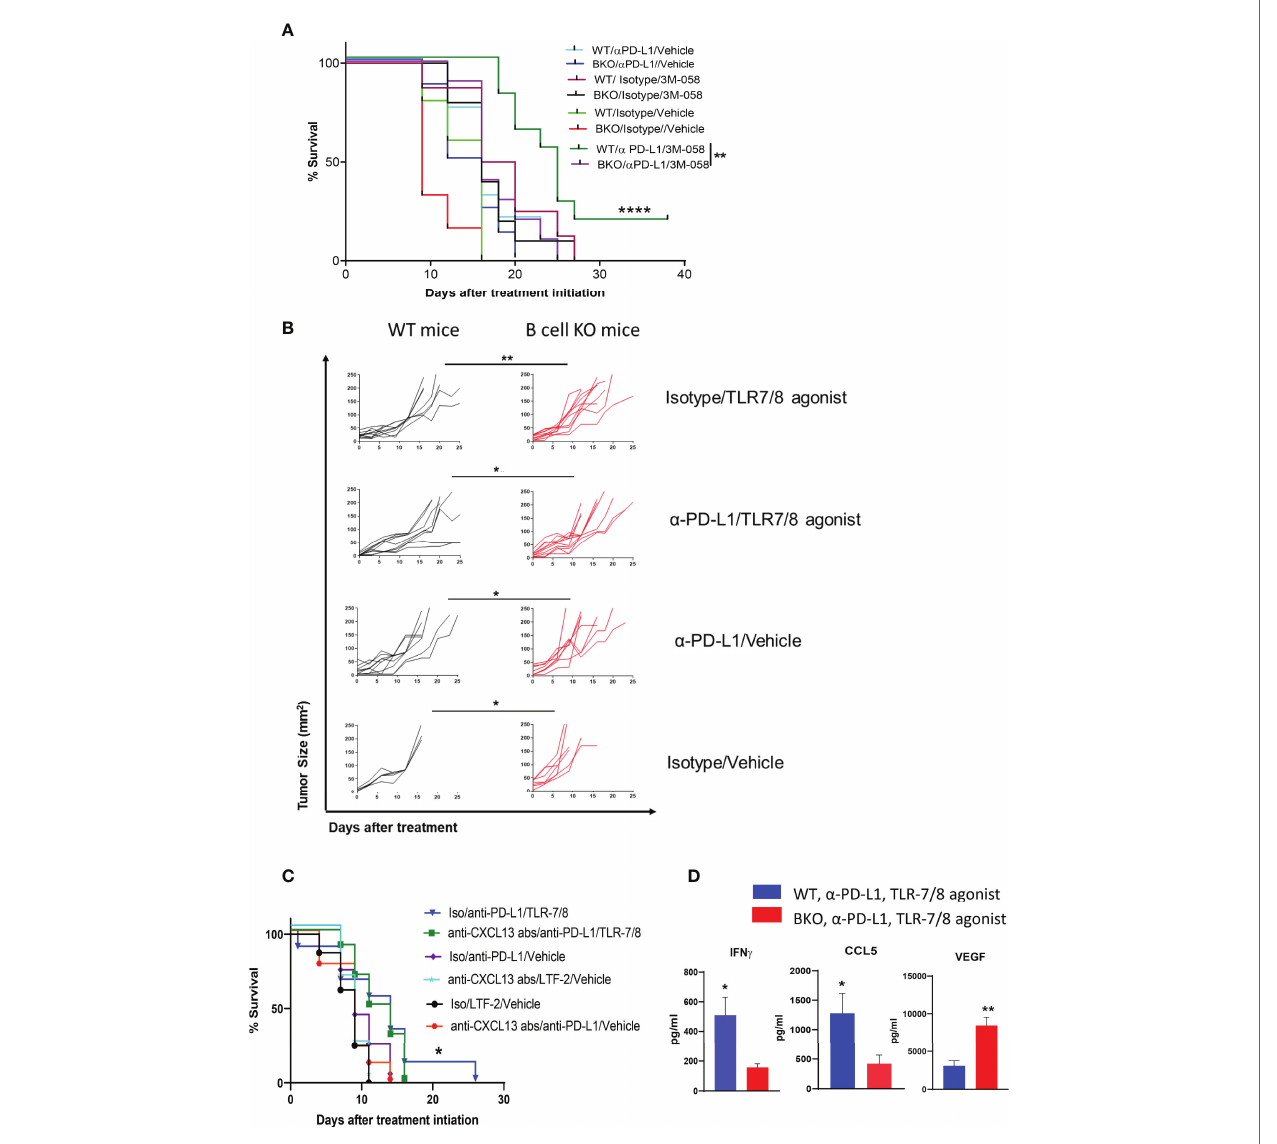
FIGURE 2 | B cells enhance anti-melanoma immunity mediated by combination therapy with a -PD-L1 plus TLR-7/8 agonist. WT, B cell KO (BKO), and anti-CXCL13 antibody treated mice bearing B16.F10 tumors (400,000 cells/tumor) were treated with a -PD-L1 or isotype control on days 7, 10, 14 and 18 after tumor cell inoculation and/or intratumoral injection of TLR-7/8 or vehicle on days 8, 12, and 16 after tumor cell inoculation. (A, C) Kaplan-Meier survival curves. ****P < 0.0001, **P < 0.01, *P < 0.05, log-rank test. LTF-2, isotype control antibody; NS, not signi fi cant. (B) Tumor size. *P < 0.05, **P < 0.01 unpaired Student ’ s t-test (5-10 mice per group). (D) Cytokine levels. *P < 0.05, **P < 0.01, unpaired Student ’ s t-test (5 mice per